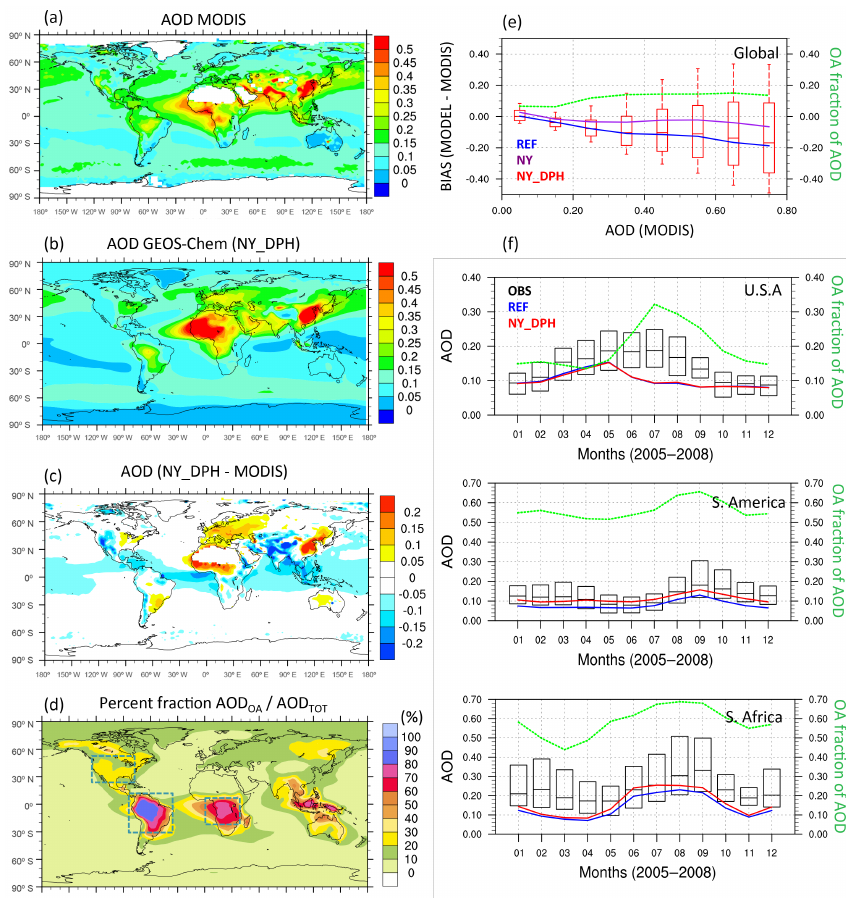
Figure 7. Comparison of 2005–2008 averaged AOD levels as measured by MODIS (Aqua and Terra) and predicted by the GEOS-Chem NY_DPH simulation. The difference (c) between modeled and observed AODs is also shown, only for days/locations when observations are available. The dependence of the model bias on the AOD levels is also shown (e) . Panel (d) shows the contribution of organic aerosols to total modeled AOD for the NY_DPH simulations, which allows us to identify regions where AOD predictions are highly sensitive to SOA predictions. Panel (f) shows the predicted and observed 2005–2008 monthly average AOD in various regions shown in (d) . The boxes show the observed medians, 25th and 75th quintiles reflecting the spatial (among grid boxes in the region) and temporal (among years)